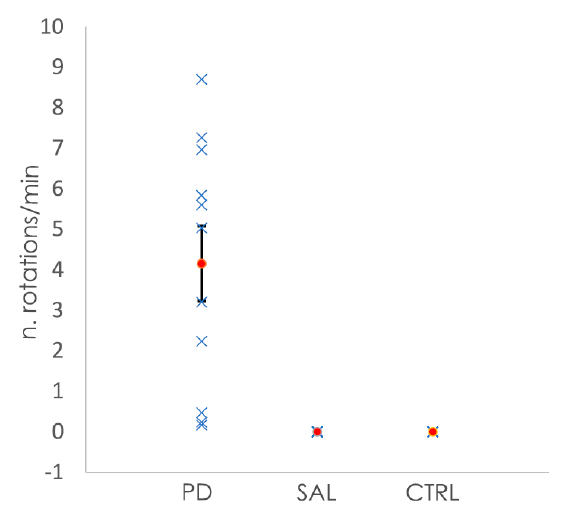
Figure 1. Representation of the number of rotations per minute shown by the mice after the injection of apomorphine. Animals subjected to the 6-OHDA lesion showed rotational behavior, while the control animals (CTRL) and animals injected with saline (SAL) did not show any rotation. In blue are the values of the number rotations per minute for each animal, while the orange dots represent the mean number of rotations per minute per group. Bars for the SEM are shown in the graph. To characterize the striatal ECM, we previously enriched our samples for ECM compo- nents by a decellularization process, by incubating the striatal slices with the ionic detergent SDS (described in the Materials and Methods section). Macroscopically, the striatal brain slices changed from a previously white-dense appearance to white-translucent structures after the decellularization process (data not shown). The decellularized sections enriched with ECM components exhibited a significant reduction in cellular content, as shown by the loss of nuclear staining in the samples from the decellularized matrices (dECM) compared with the native (ECM; Figure 2a). In addition, the reduction in the intracellular content was illustrated by a marked decrease in the immunodetection of the intracellular protein actin in the samples from the decellularized matrices (Figure 2c). To monitor the preservation of the extracellular matrix components after the decel- lularization process, we performed Alcian Blue staining. This cationic dye is commonly used for the staining of glycosaminoglycans [43], which are eminently present in the brain ECM [14]. From Figure 2b, it was confirmed that glycosaminoglycans were preserved after the decellularization process. To assess the presence of extracellular matrix proteins in the decellularized slices, we also performed immunostaining with specific antibodies against the ECM proteins collagen IV and fibronectin. As shown in Figure 2d, it was possible to detect both proteins after the decellularization process, highlighting the preservation of extracellular matrix components, similar to what was observed for the ECM protein brevican by Western blot (Figure